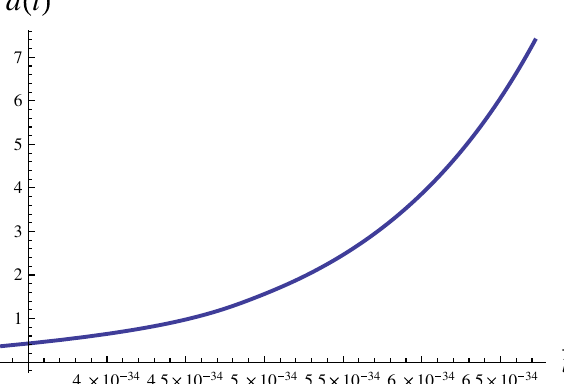
Fig. 8 Illustration of the typical evolution of w φ with respect to ln ( ¯ a ) . We assume that γ = 1 . 16 × 10 − 69 s 2 and ¯ a 0 = 1 at the beginning